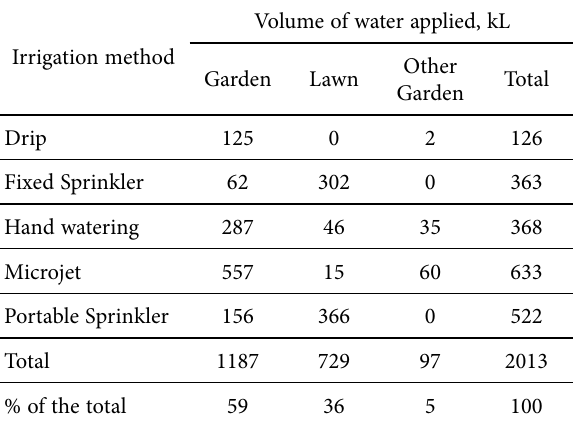
Table 5. Variation of the total volume of water applied with irrigation systems and zone during the trial period